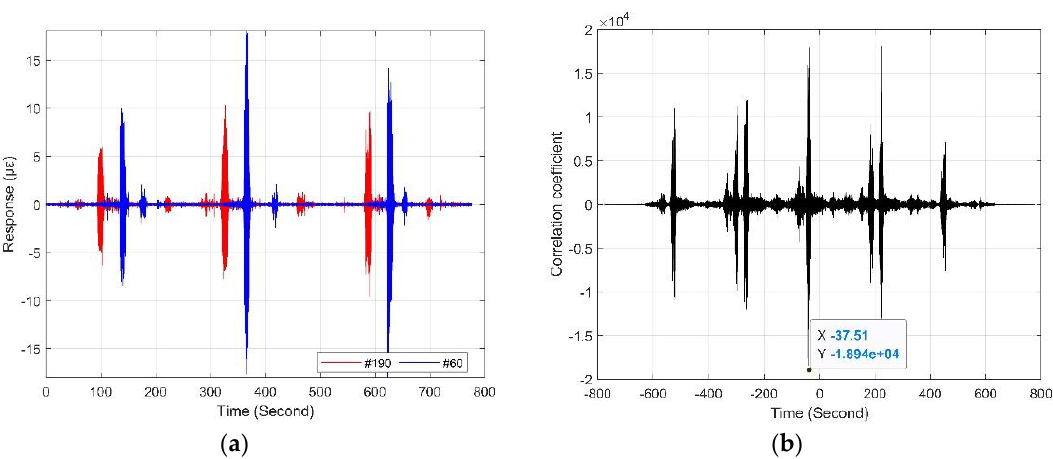
Figure 7. ( a ) Original time series of vibrations at zones #60 and #190; ( b ) time lag between zones #60 and #190.